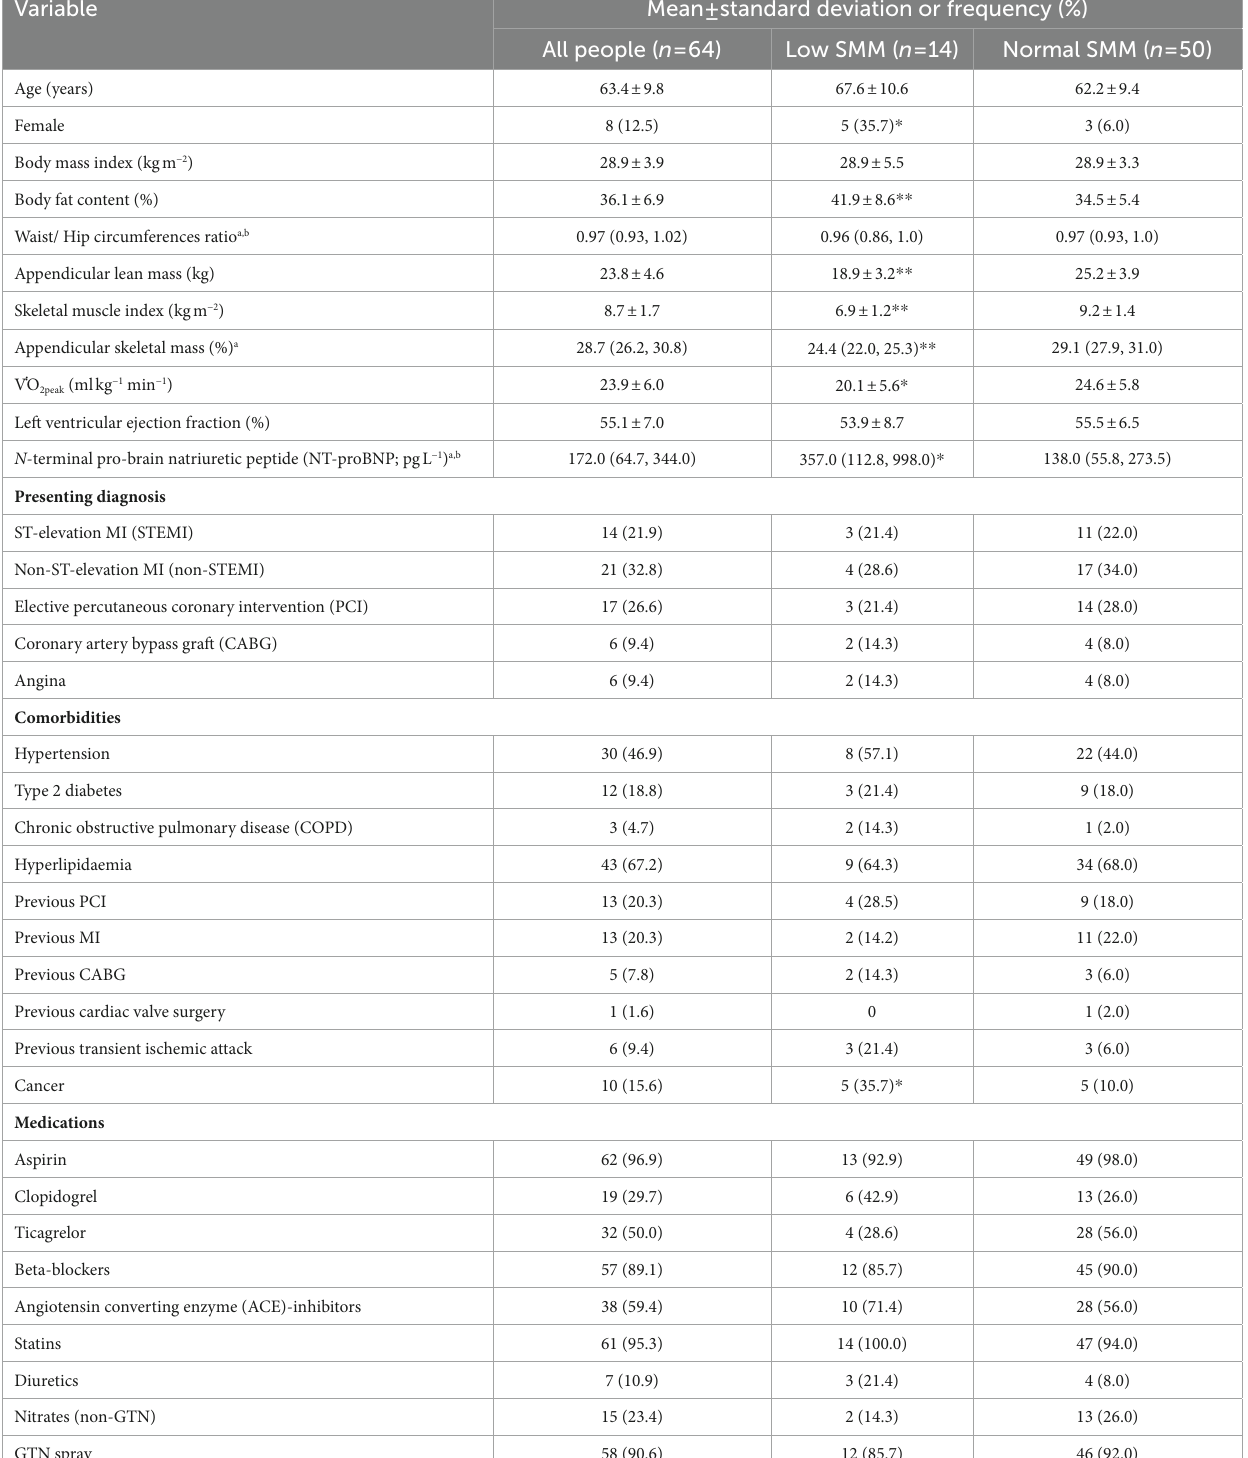
TABLE 1 Patient baseline characteristics.